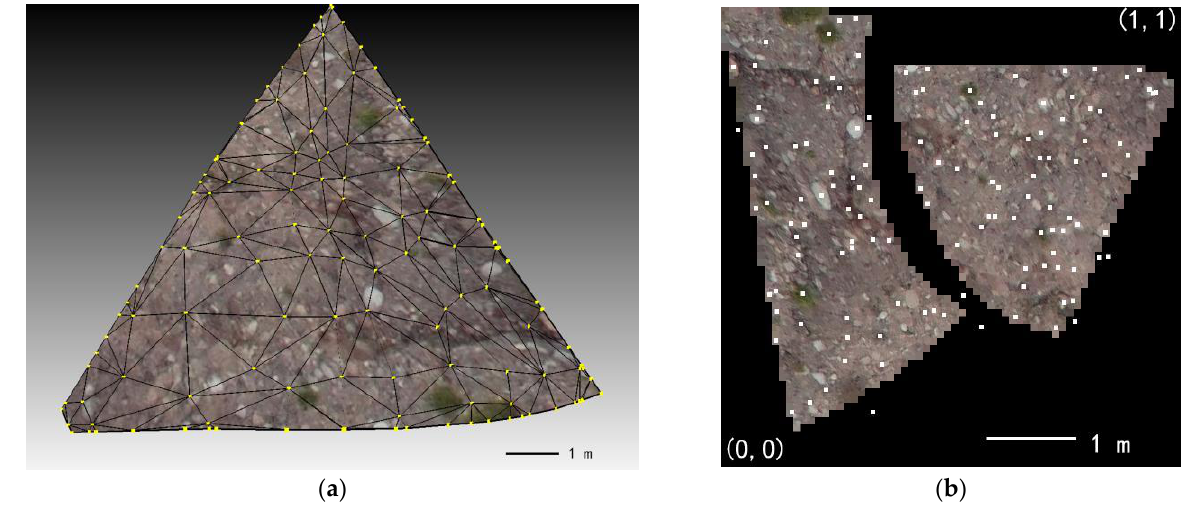
Figure 3. The composition of the 3D model. ( a ) The vertices of the 3D model and the triangulation connecting the vertices. ( b ) The texture image of the 3D model and the texture coordinates corresponding to the vertices.